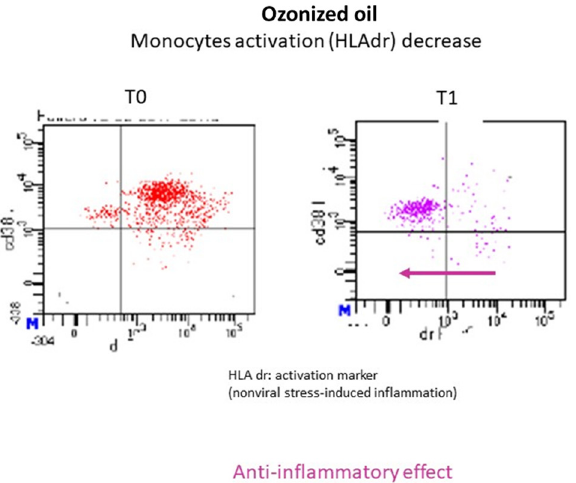
Figure 12. FACS analysis of blood monocytes (cd38, vertical axis). Activated monocytes are detected by analyzing HLAdr (horizontal axis). The number of HLAdr-positive activated monocytes was decreased (arrow) after 1 week of HOO treatment (T1, right panel) as compared with those detected in the same subject before treatment beginning (T0, left panel).